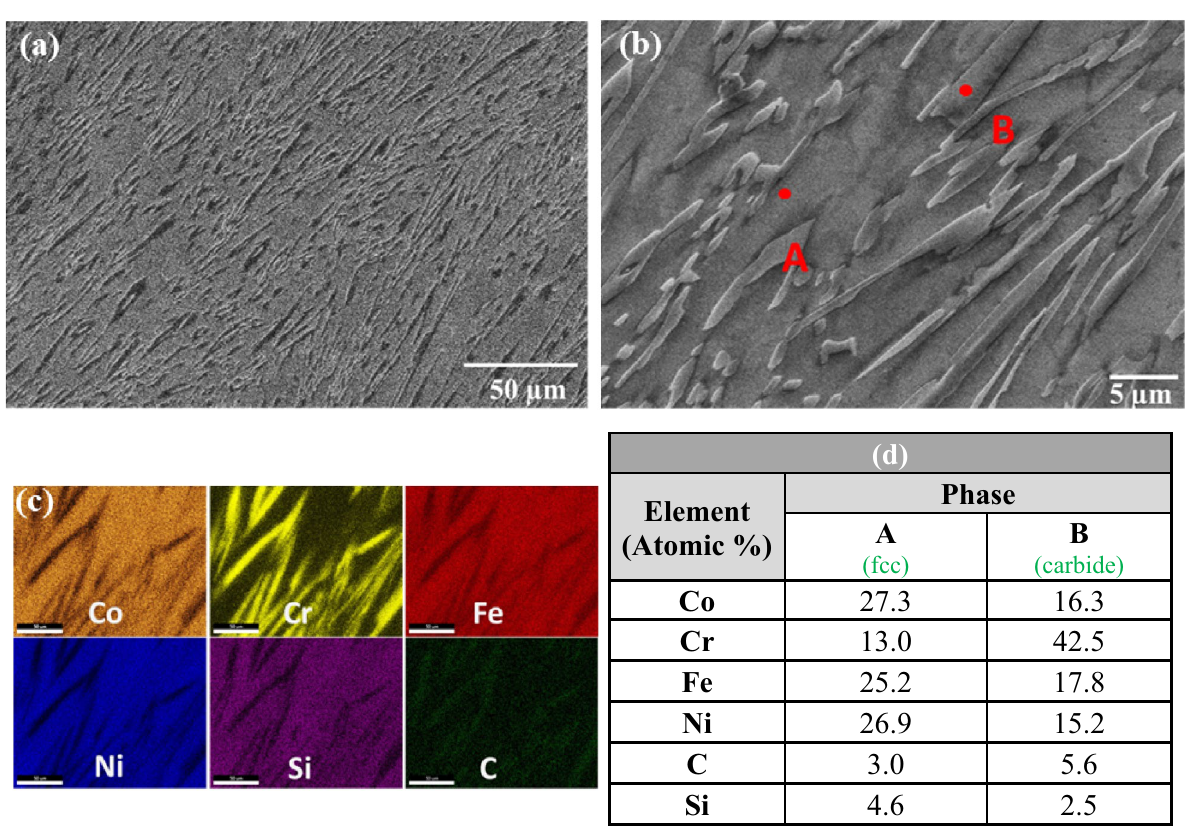
Figure 3. ( a ) SEM image of sample S-2, ( b ) magnified view, ( c ) elemental mapping, ( d ) EDS results at the indicated